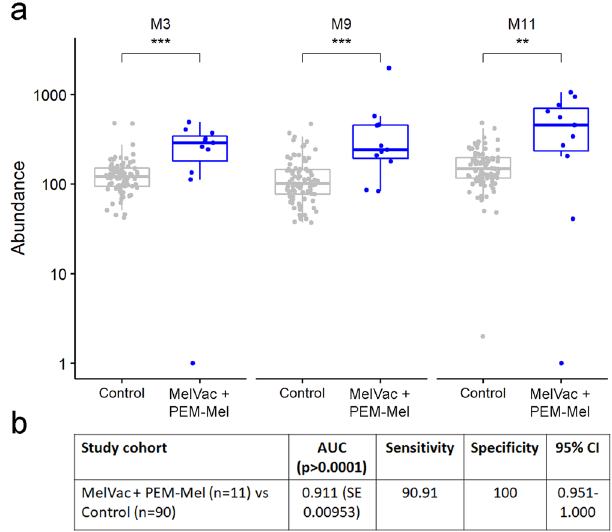
Fig. 5 Antibody reactivity to epitopes of melanoma-antigens is associated with immunotherapy. a Box plots showing the IgG response to peptides containing the 3 epitopes that were most differentiating